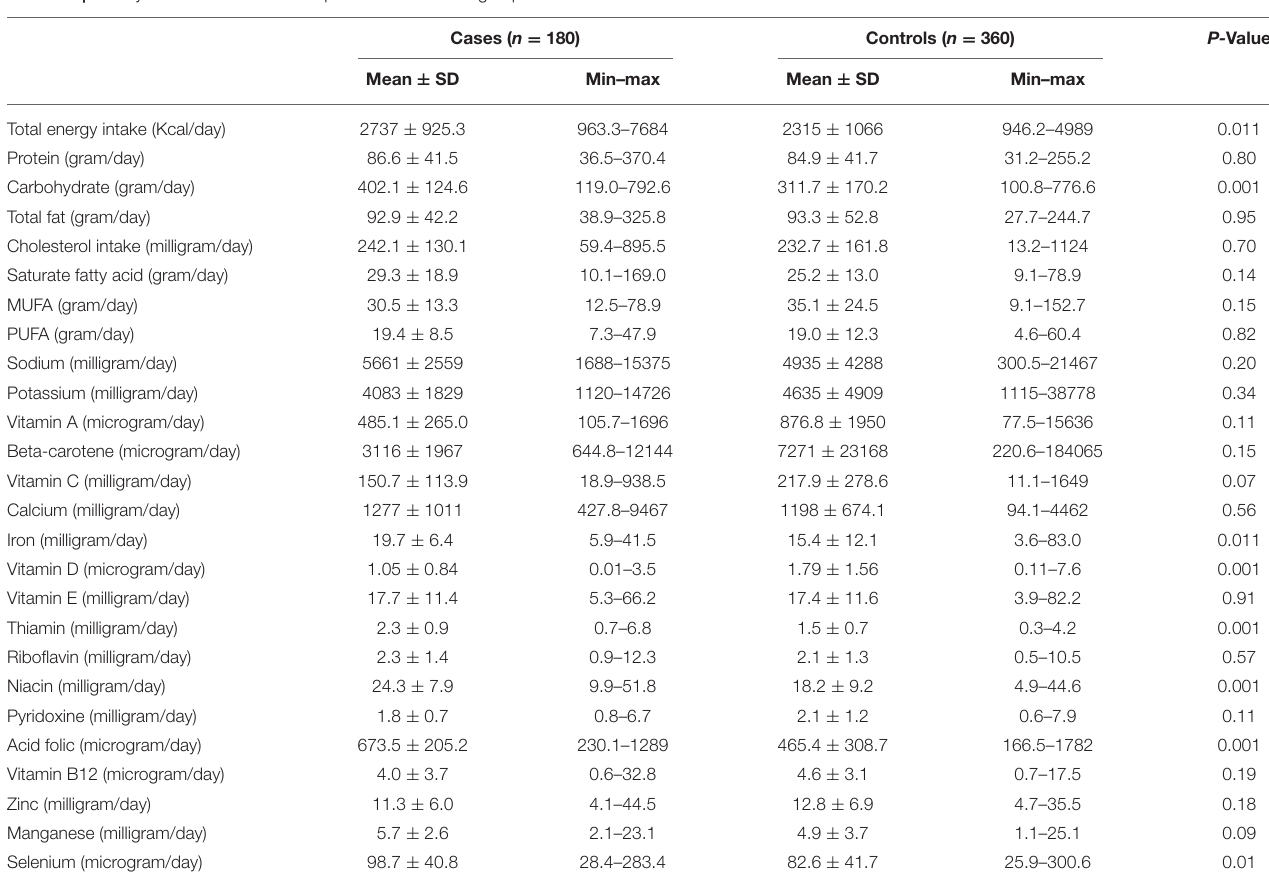
TABLE 2 | Dietary intake of breast cancer patients and control